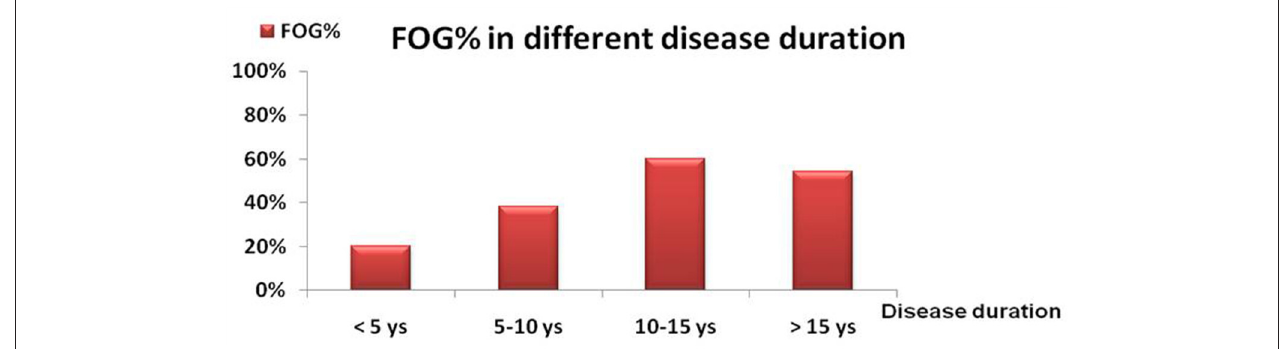
FIGURE 2 | The frequency of FOG (%) in different symptomatic durations. The frequency of FOG was 20% in PD patients with clinical course of < 5 years; 38.42% in PD patients with a course with 5–10 years; 60.27% in PD patients with a course with 10–15 years and 54.0% in PD patient with a course with > 15years.